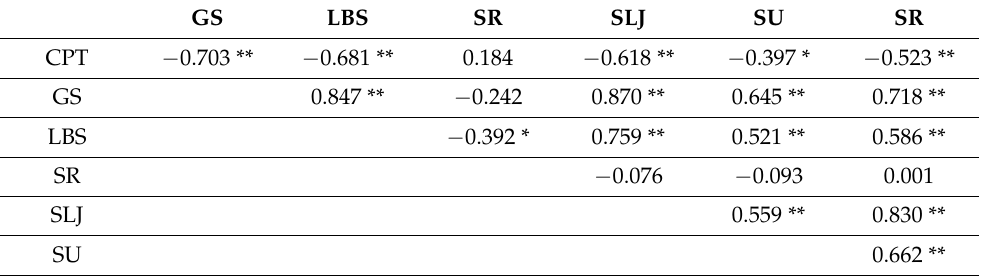
Table 6. Relationship of improvement physical fitness test and Korea firefighter physical fitness test on correlation